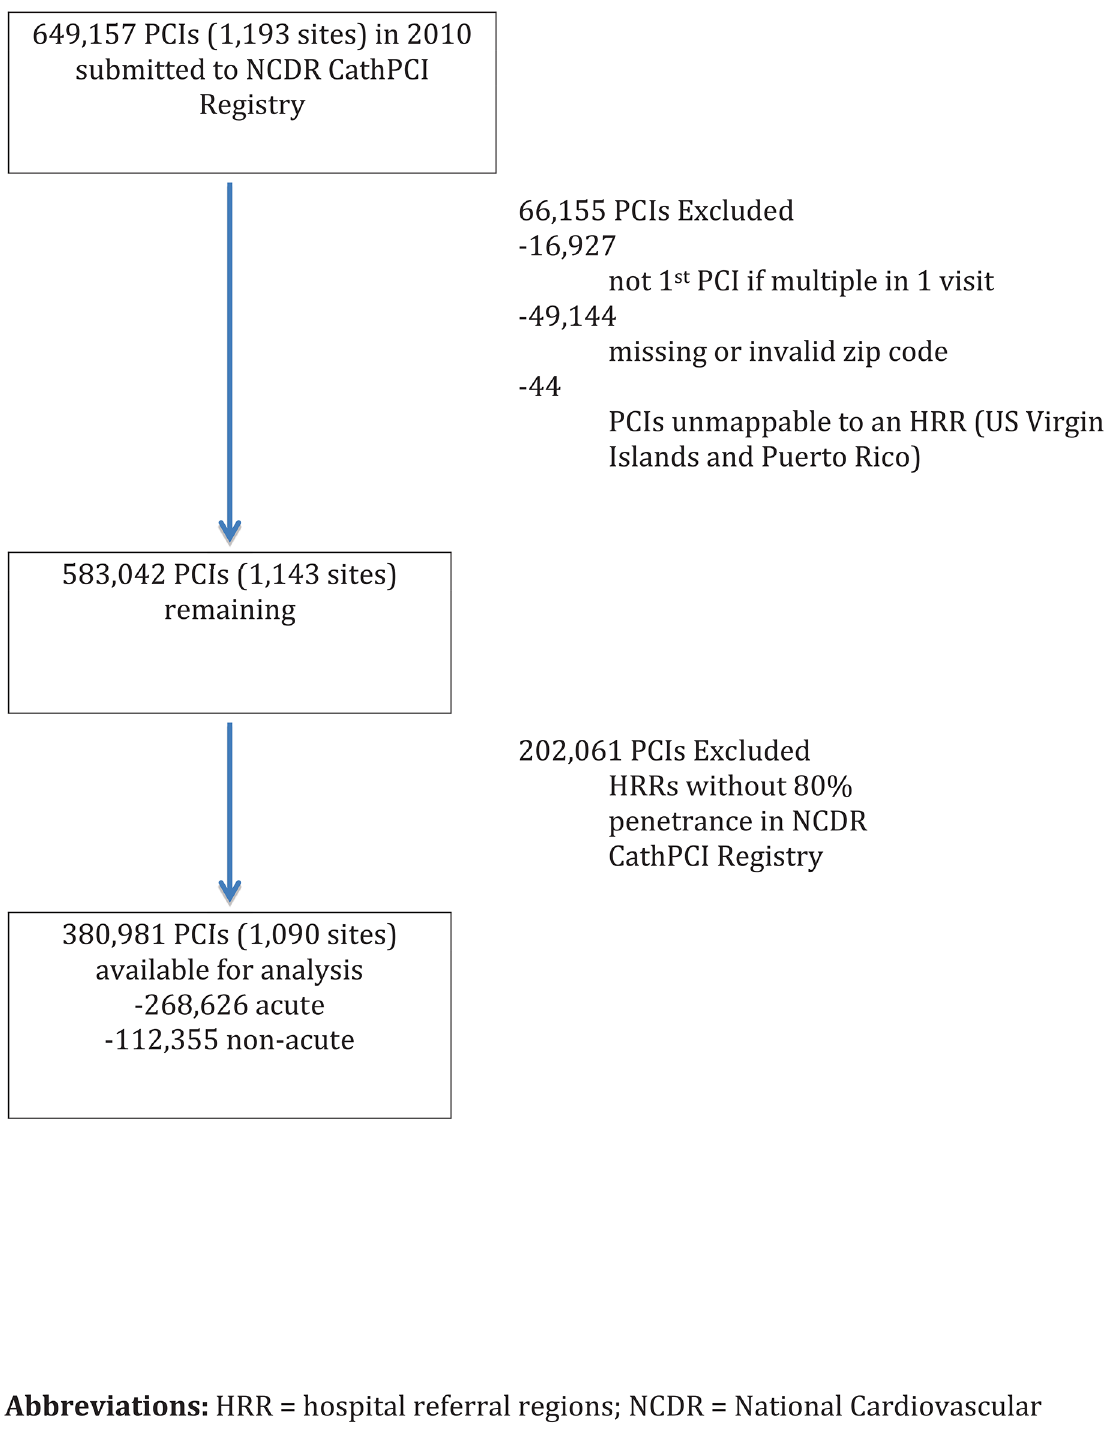
Fig 1. Final cohort available for primary analysis. Shown is the final cohort for the primary analysis and the PCIs that were excluded.